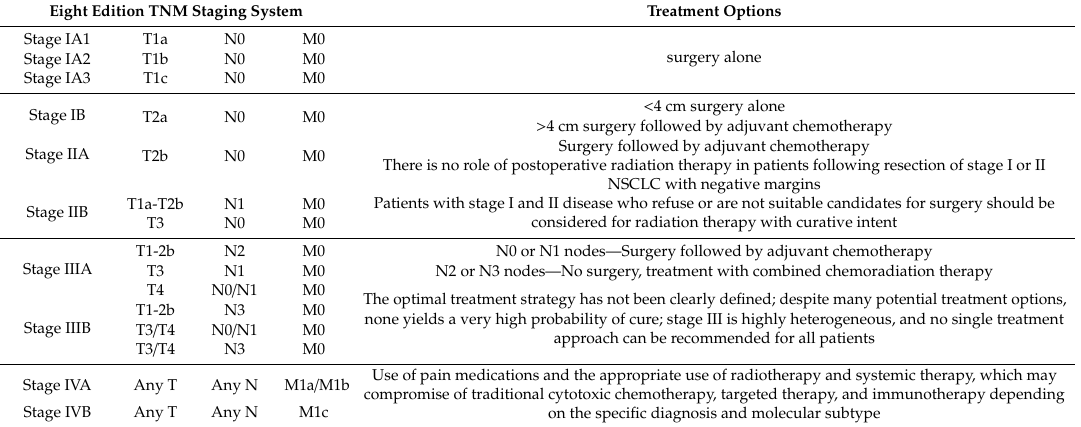
Table 1. Therapeutic strategies in non-small cell lung carcinoma (NSCLC) based upon the stages of lung cancer adapted from the 8th Edition of TNM